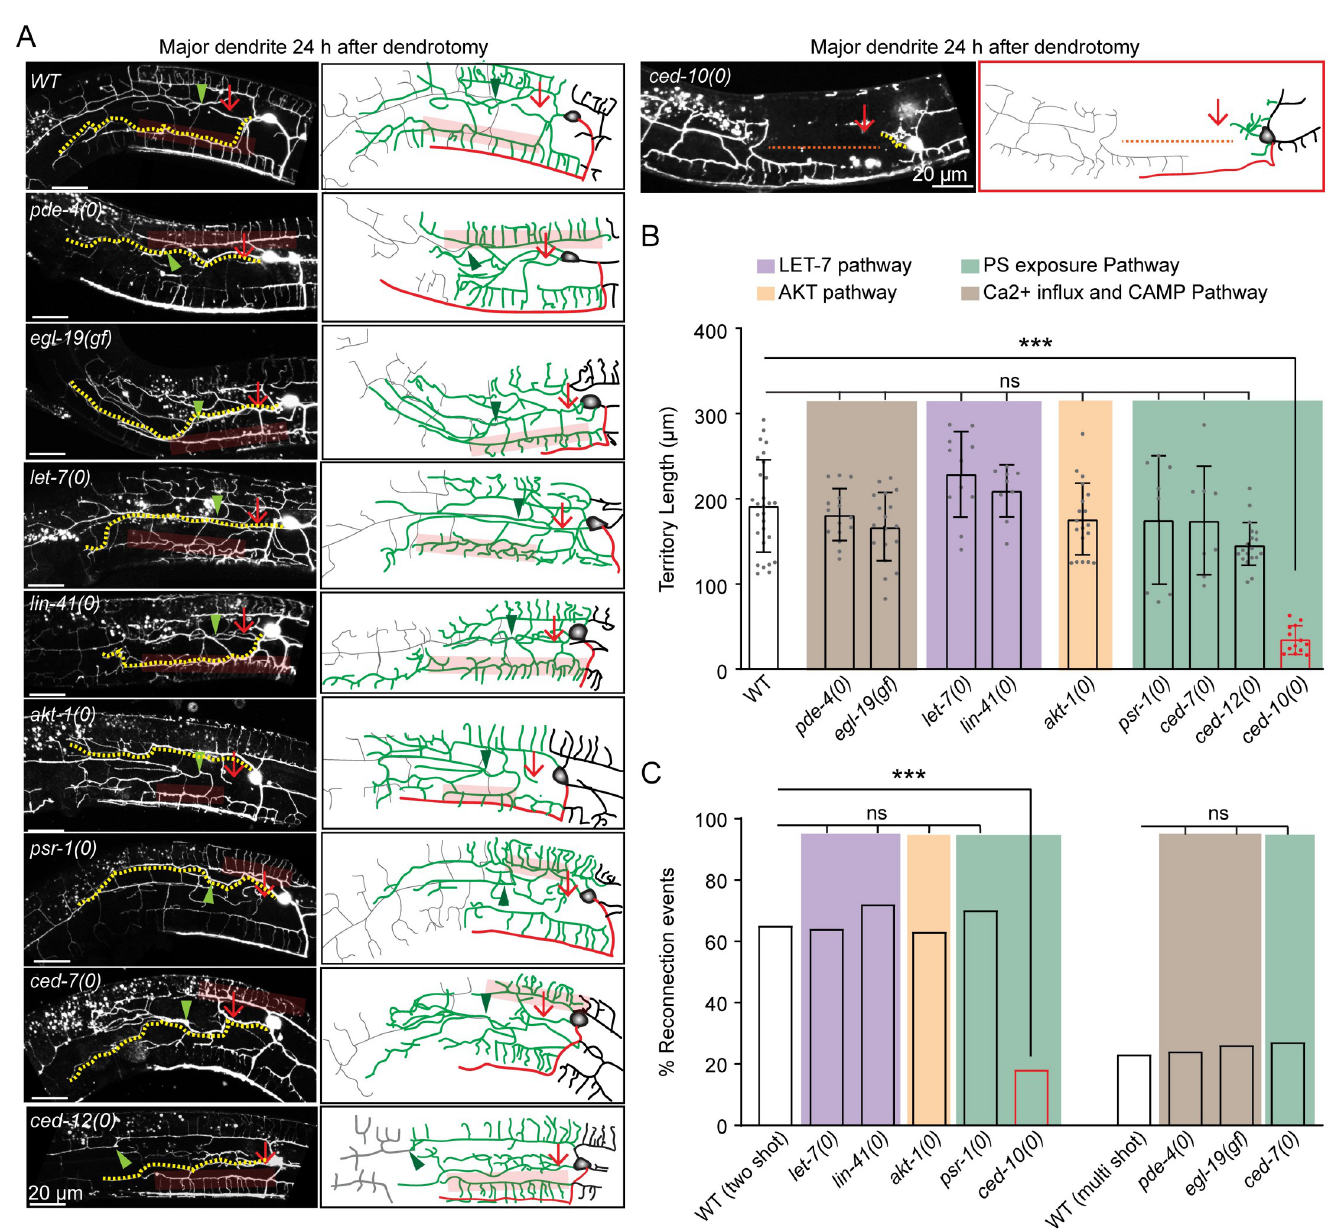
Fig 4. Dendrite regeneration is independent of conventional axon regeneration molecules. (A) Confocal images of the major dendrite regeneration events in the wildtype, pde-4(0) , egl-19(gf) , let-7(0) , lin-41(0) , akt-1(0) , psr-1(0) , ced-7(0) , ced-12(0) , and ced-10(0) backgrounds. This experiment is conducted in a strain expressing the wdIs52 ( pF49H12 . 4 ::GFP) reporter. The illustrations on the right indicating site of dendrotomy (red arrow), regenerated dendrites (green), distal dendritic part (grey), territory length (yellow dotted lines), reconnection events (green arrowheads) and menorah-menorah fusion (faded red boxes). (B-C) The quantification of the territory length (B) and the percentage of reconnection events (C) done from the dendrotomy experiments shown in A. For B & C, N = 3–4 independent replicates, n (number of regrowth events) = 8–19. Statistics, For B, One-way ANOVA with Tukey’s multiple comparison test considering p < 0.05 � , 0.01 �� , 0.001 ��� , and for C, Fisher’s exact test considering p < 0.05 � , 0.01 �� , 0.001 ��� . Error bars represent SD. ns, not